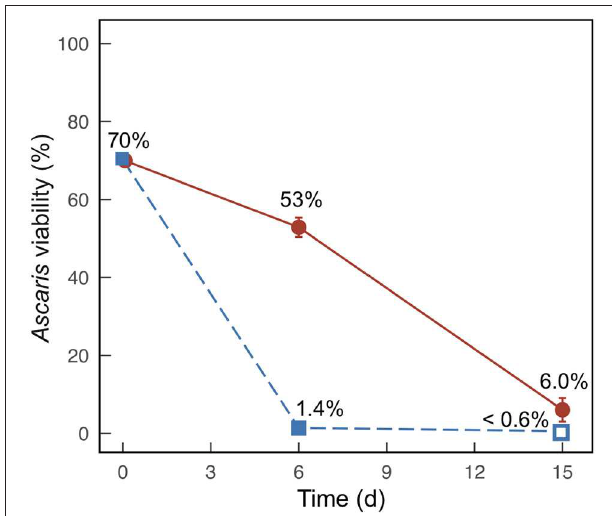
FIGURE 3 | Average percent viability of Ascaris eggs collected from duplicate batch fermentation media bottles for Experiment 2 with banana mash added at 0% (m/m) ( • ) and 20% (m/m) ( (cid:4) ). Error bars indicate the range between the two samples. Open symbols indicate that viability was below the detection limit